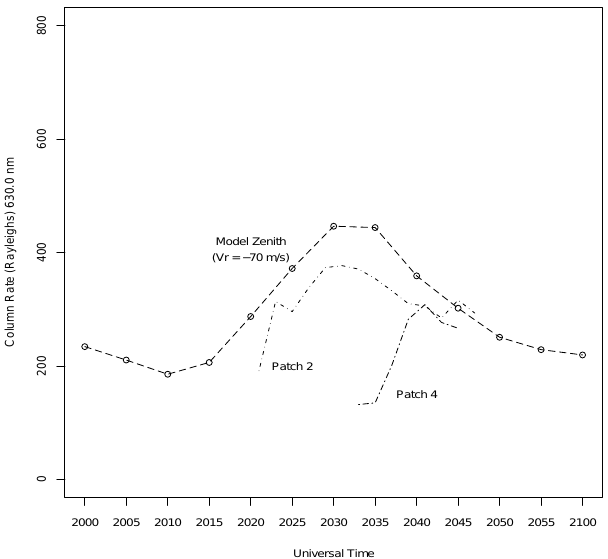
Figure 11. Model column emission rates of atomic oxygen arising from radiative recombination (dashed line and open circles), and 630.0nm airglow emissions corresponding to patches 2 and 4 plot- ted using dot-dash lines.